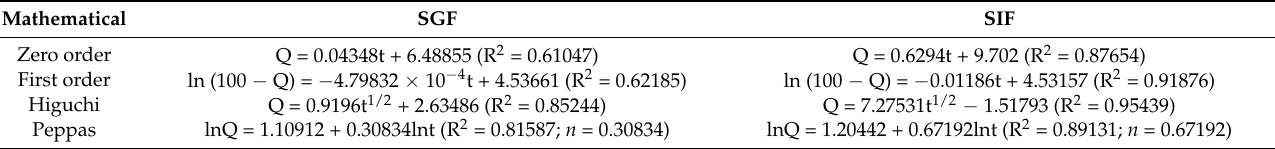
Table 4. Kinetic release parameters of GLO microcapsules in SGF and